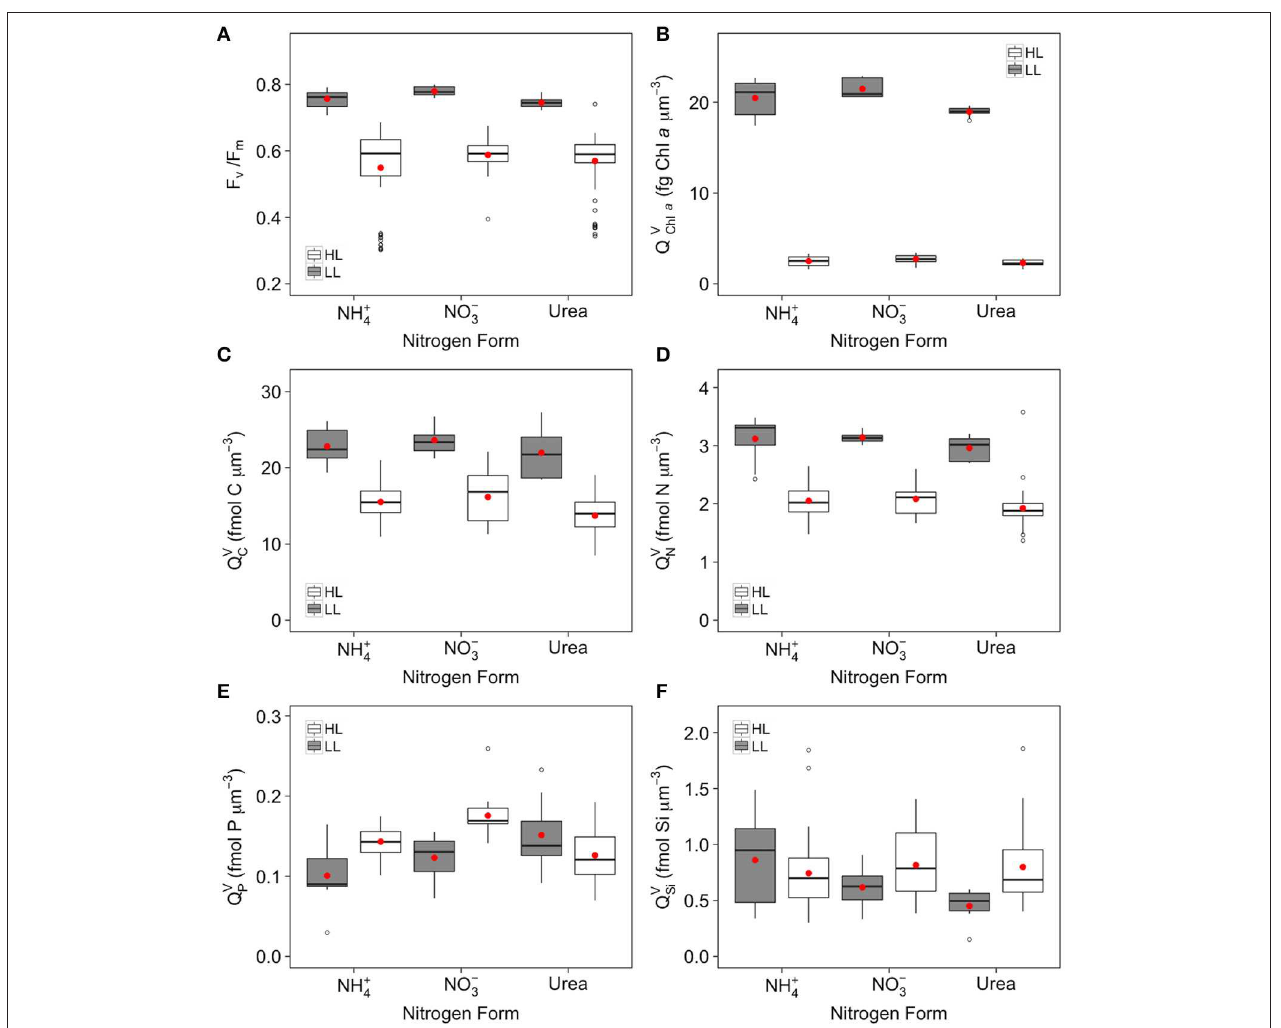
FIGURE 2 | Box plots of PSII maximum quantum efficiency (F v /F m ) (A) volumetric quotas for Q V Chla (B) , Q V C (C) , Q V N (D) Q V P (E) and Q V Si (F) for cells of C. gelidus acclimated to NH +